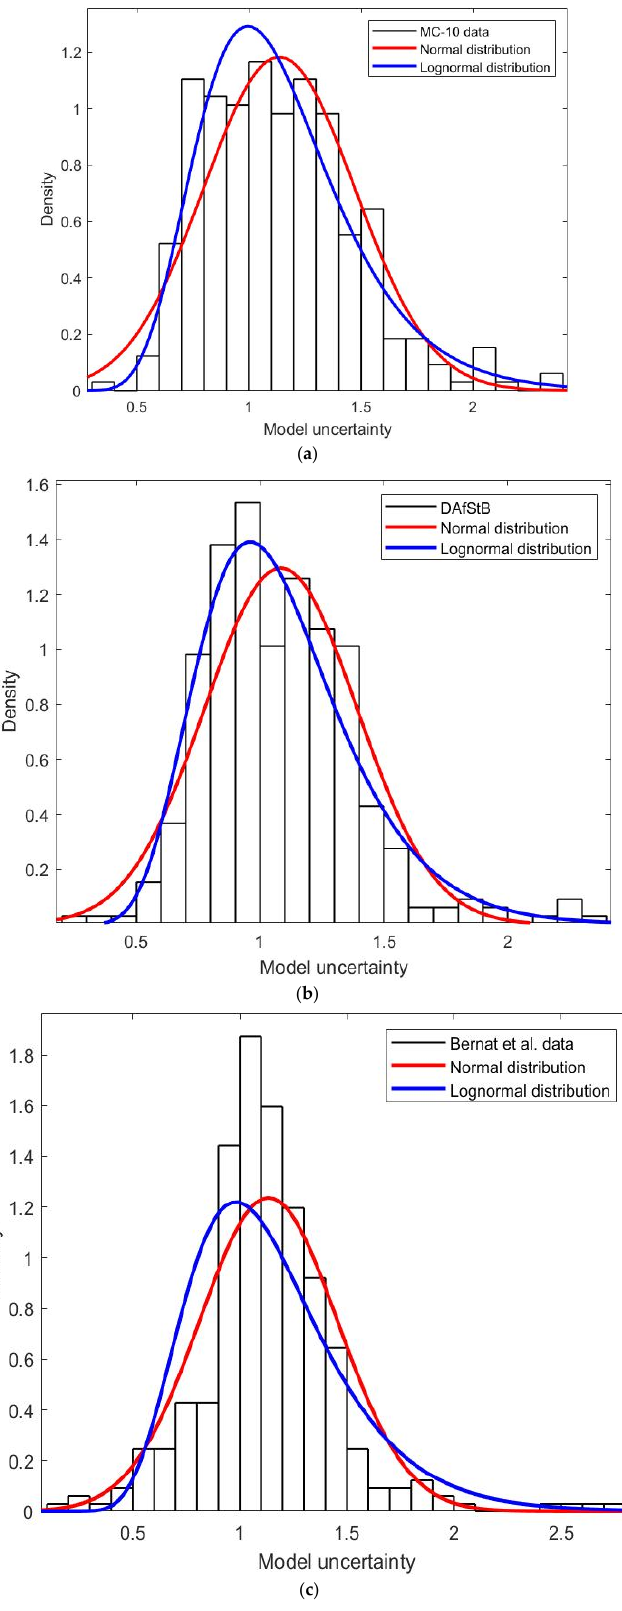
Figure 6. Model uncertainty distribution plots—theoretical PDF and frequency histogram plots. ( a ) PDF for MC-10 model. ( b ) PDF for DafStB model. ( c ) PDF for Bernat et al., model.